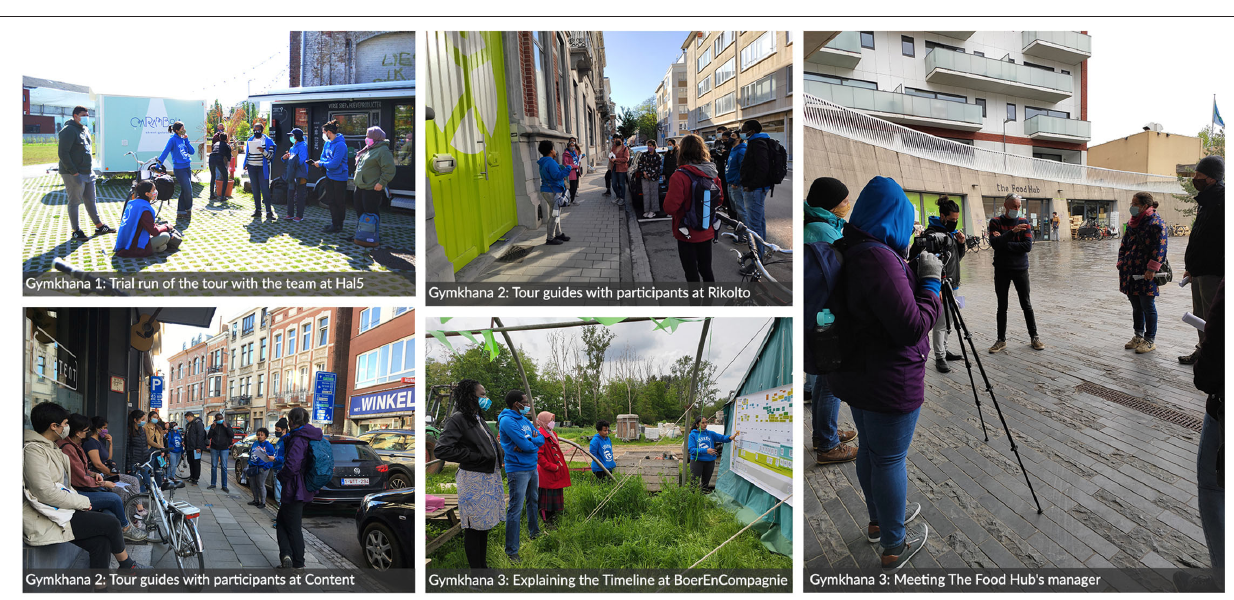
FIGURE 10 | Summary of pictures conducting the LeuvenGymkhana 2.0 tours in May